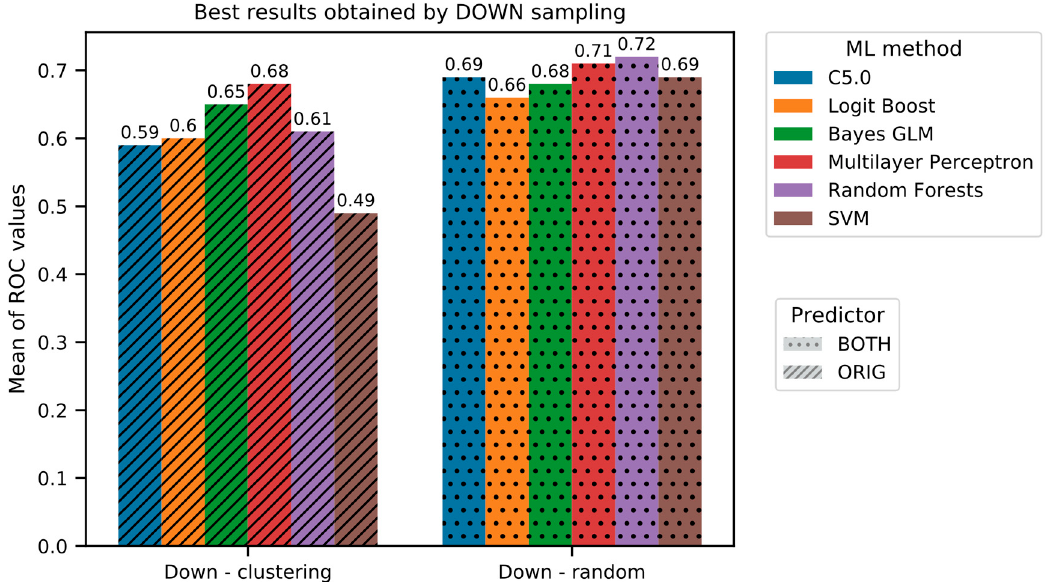
Figure 2. Highest mean accuracy values in down-sampling subset, corresponding to each ML method. Each color bar represents the different classification models. The texture of the bar represents the input predictor from which each model has been generated. The two different down-sampling methods are represented grouped in the X axis.